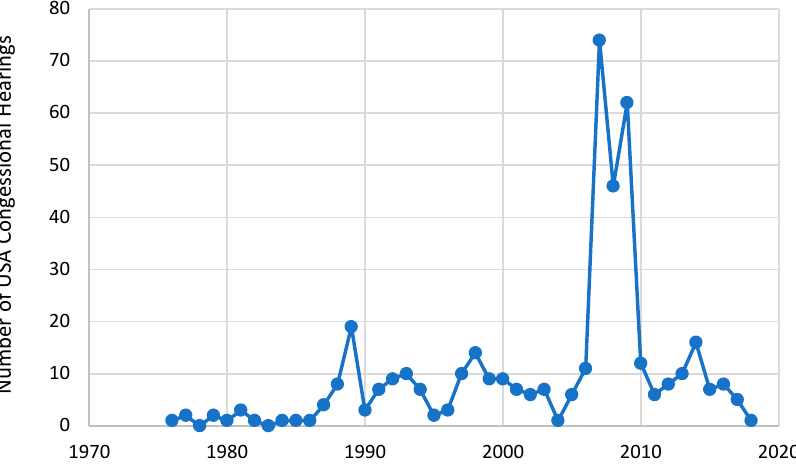
Figure 9. Annual number of USA Congressional Hearings on climate change, whose description contains either of the phrases “climate”, “greenhouse” and “global warming”; the first instance appears in 1976 (data source: [91]; data coverage: 1946–2018).